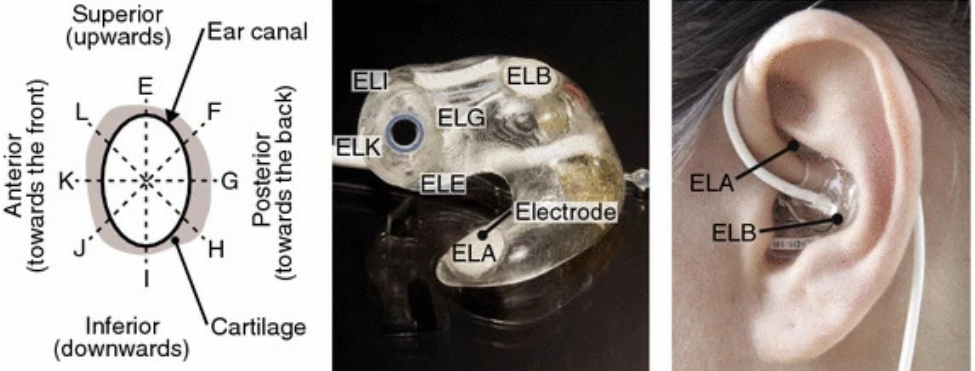
Figure 5. An example of a wearable EEG device